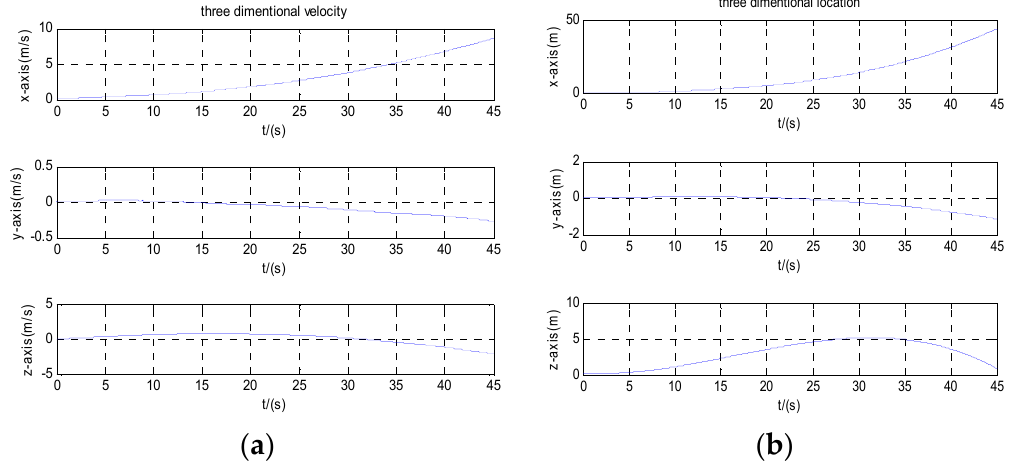
three dimentional location